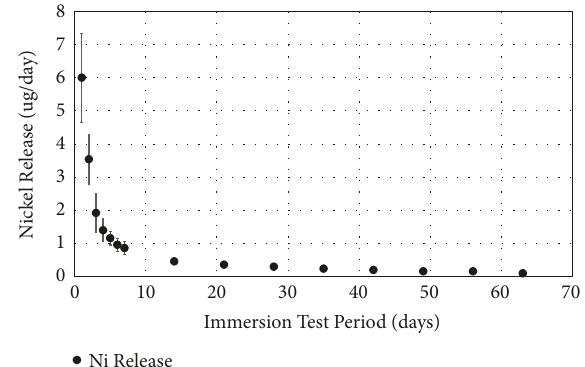
Figure 8: Ni ion release of the porous Nitinol for 63 days. Specimens exhibited Ni ion release below the acute tolerable limit of 70 𝜇 g/day for period up to the first 24 hours and below the long-term tolerable limit of 35 𝜇 g/day beyond the 1st